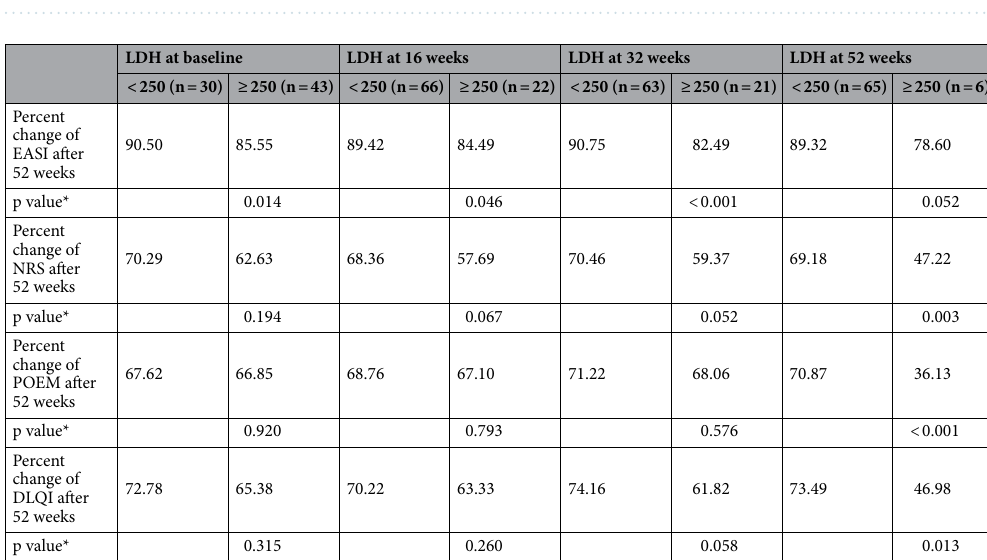
Table 4. The difference of efficacy, according to LDH—elevated LDH at baseline, 16 and 32 weeks showed inadequate treatment response in EASI. *p values were obtained by two sample independent t-test.